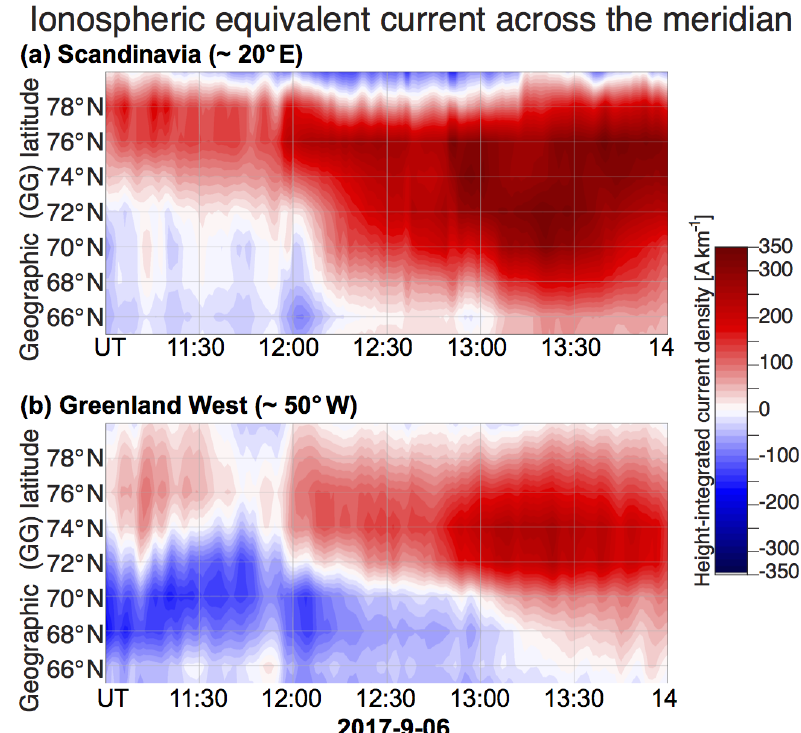
Figure 3. Latitudinal distribution of ionospheric equivalent current (including Sq current) eastward component, (a) crossing Scandinavian meridian (20 ◦ E) and (b) crossing Greenland meridian (50 ◦ W), based on the densely distributed magnetometer network. The Spherical El- ementary Current System (SECS) technique is used. Data are displayed in a latitude–time spectrogram during 11:00–14:00UT, 6 September 2017, i.e. around the X9.3